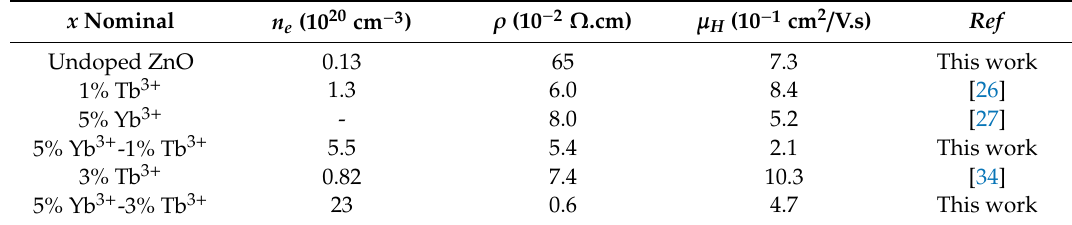
Table 2. Electrical parameters of undoped and co-doped ZnO thin